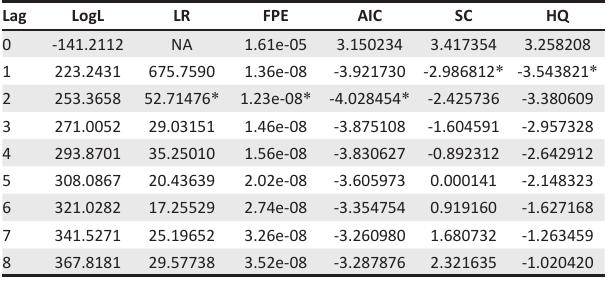
TABLE 3-A1: Lag length criterion test. TABLE 5-A1: Vector autoregressive residual heteroskedasticity test: No cross